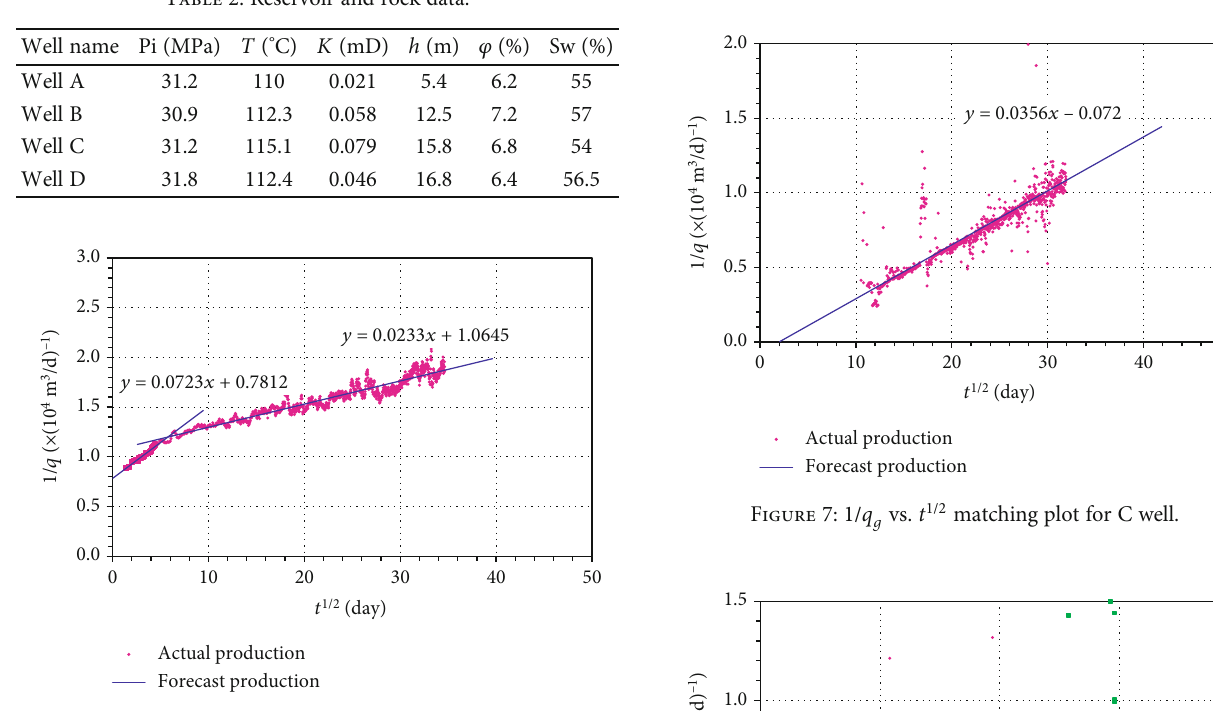
Figure 5: 1/ q vs. t 1/2 matching plot for A well. g